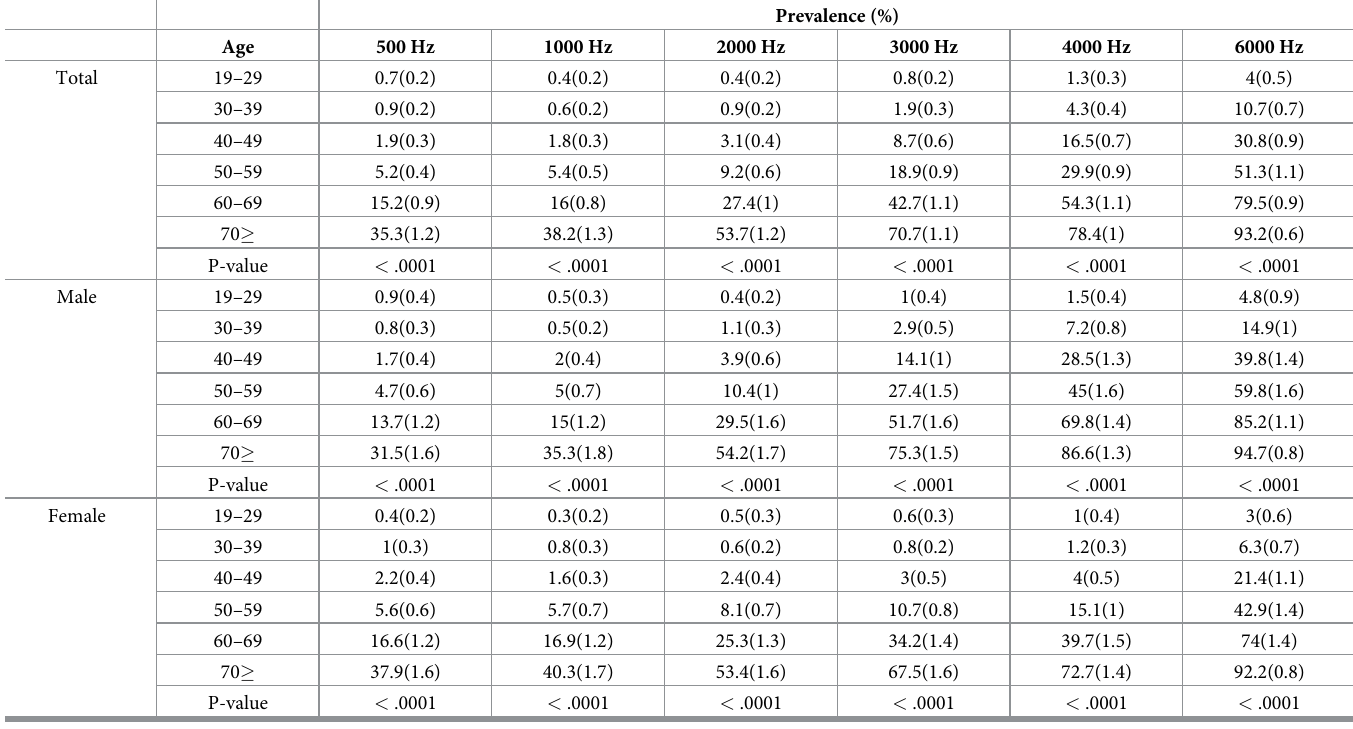
Table 2. Prevalence of hearing impairment (more than 25 dB in the better ear) at each frequency by decade